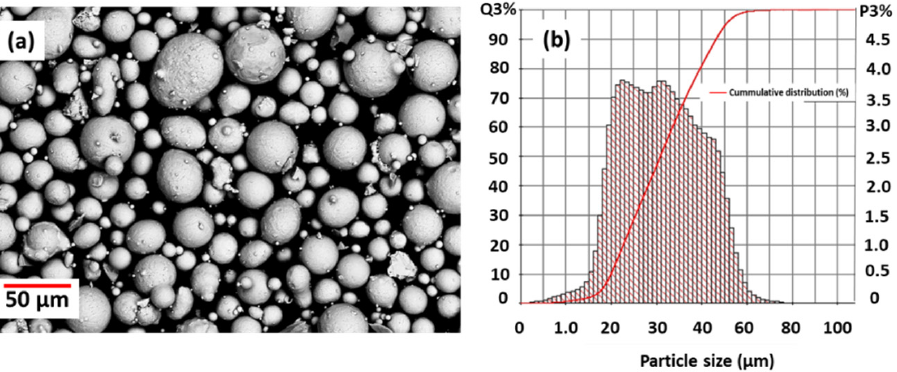
Figure 3. The modified 1.2343. ( a ) SEM morphology of the particles. ( b ) Histogram and cumulative distribution of the particle size, d50–30.8 µm.